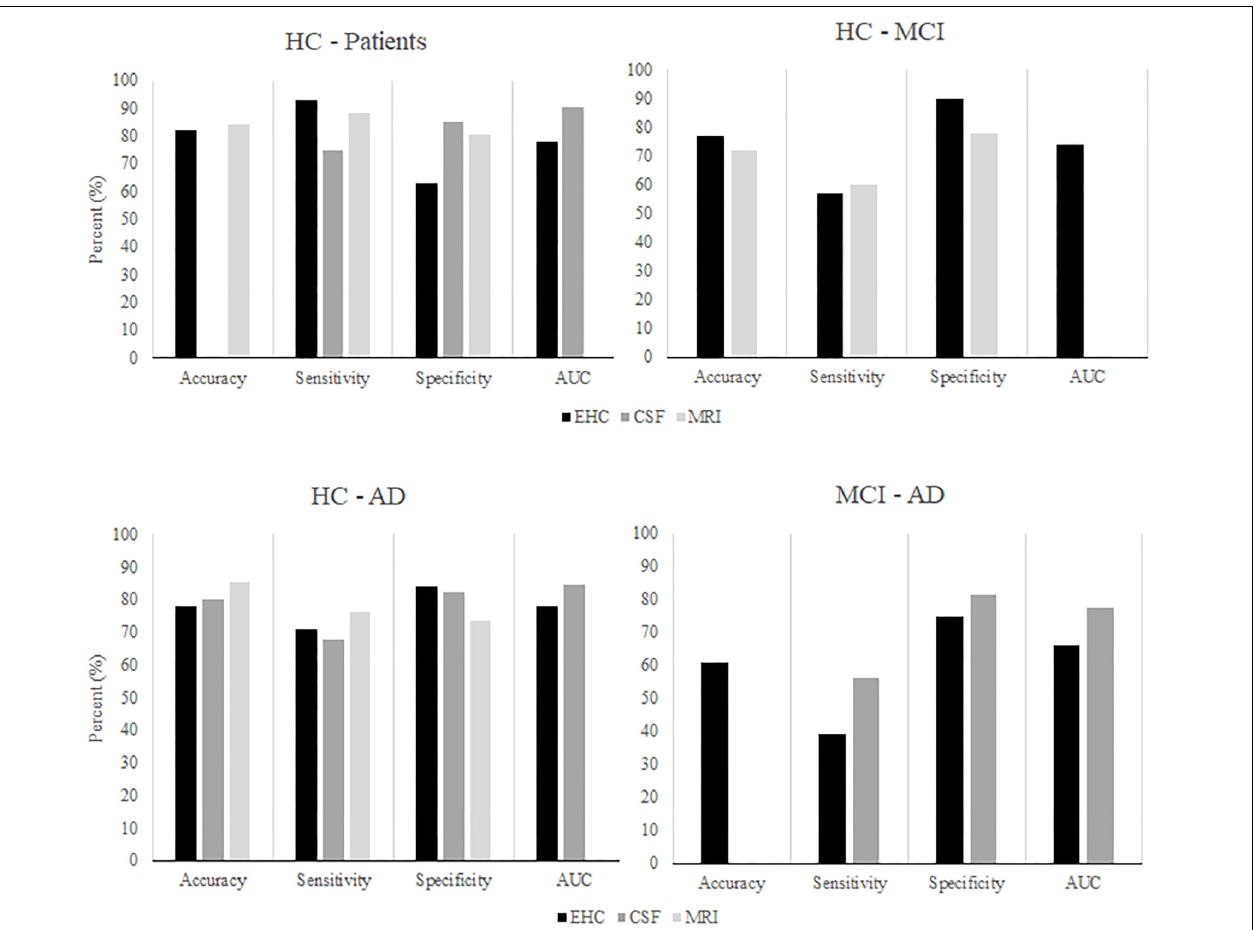
FIGURE 7 | After Henriques et al. (2018). The classification performance of algorithms using CSF or MRI markers to classify HC, MCI patients, and AD patients, compared to classification performance using EHC parameters.